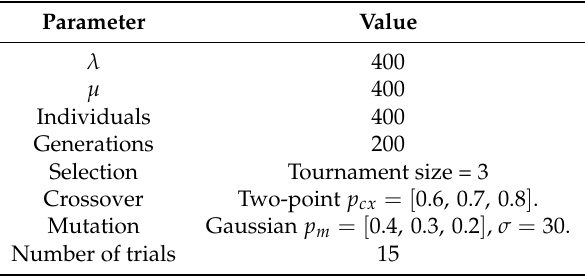
Table 3. Parameters of the GA (genetic